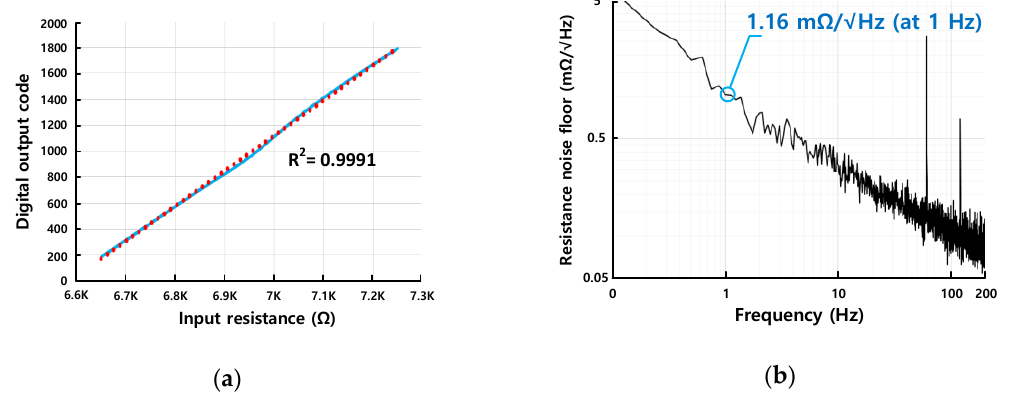
Figure 11. ( a ) Linearity expressed as the ratio of the digital output code to the input resistance. ( b ) Resistance noise floor.